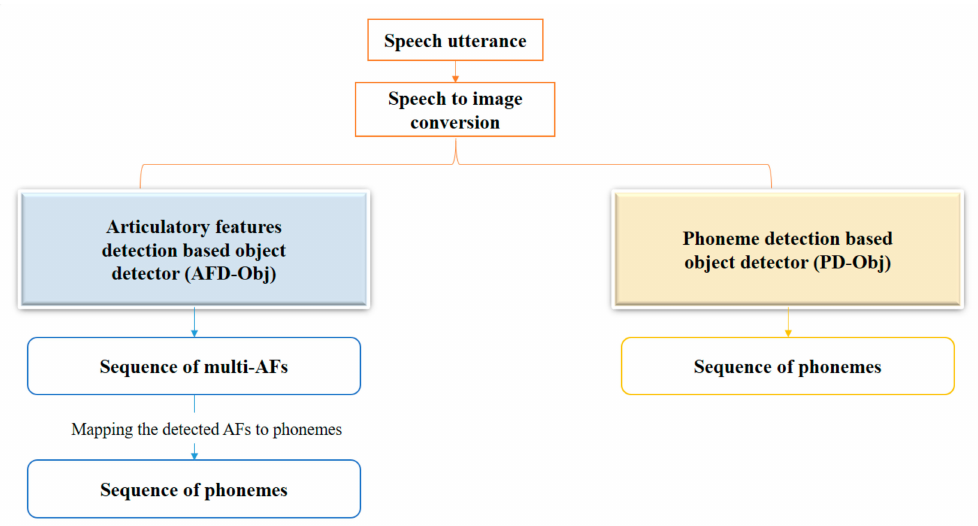
Figure 2. The proposed